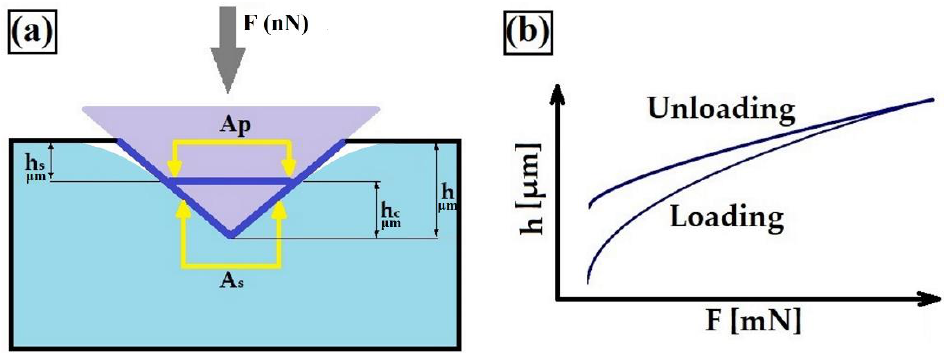
Figure 2. Methodology of the instrumented indentation test: ( a ) scheme measurement; ( b ) example of a typical load–displacement curve obtained during nanoindentation test.